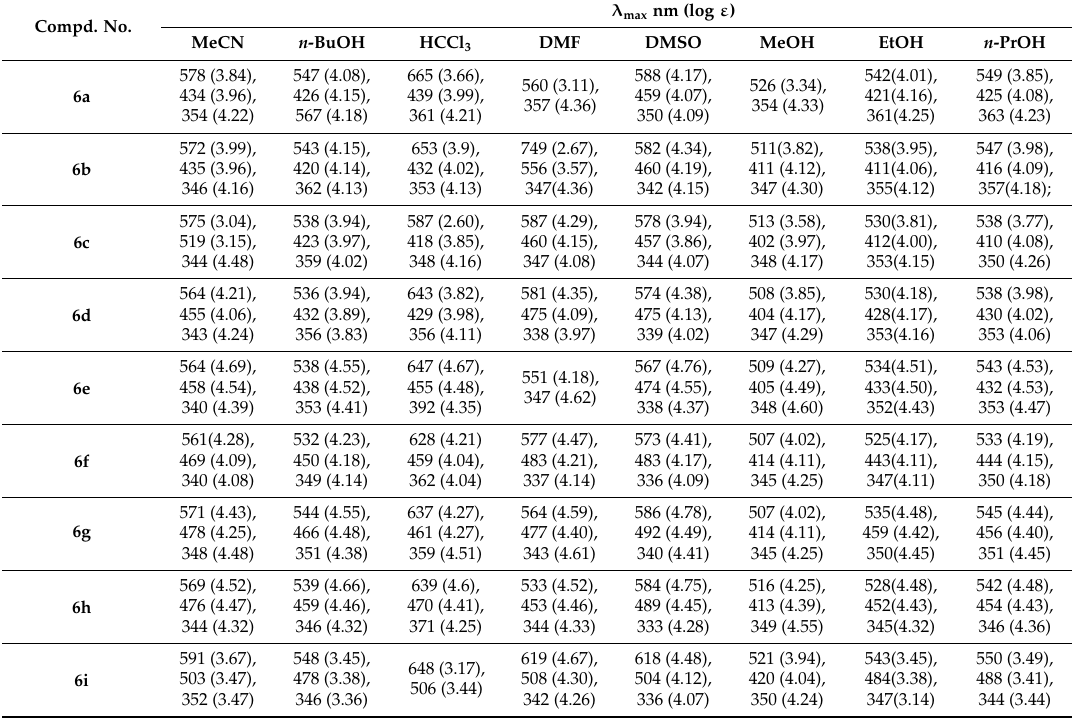
Table 3. Electronic spectral data of 4-(5-arylazo-2-hydroxystyryl)-1-methylpyridinium iodide 6a – i in various